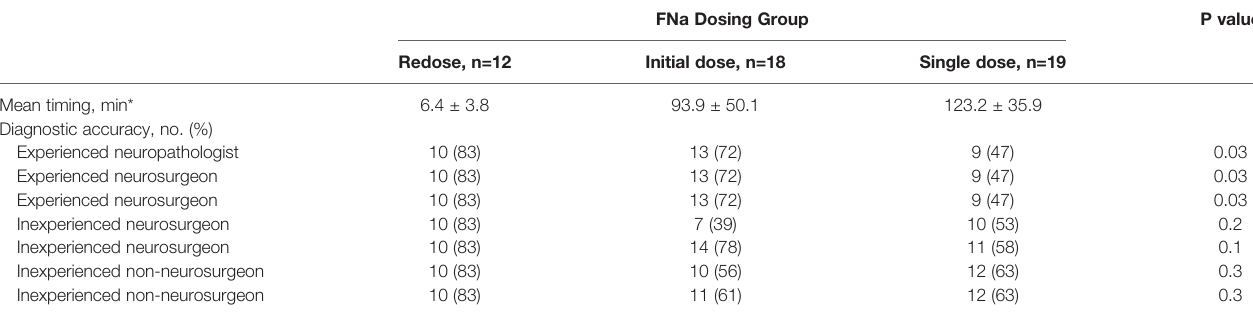
CLE, confocal laser endomicroscopy; FNa, fl uorescein sodium. *Mean timing of CLE biopsy imaging after FNa